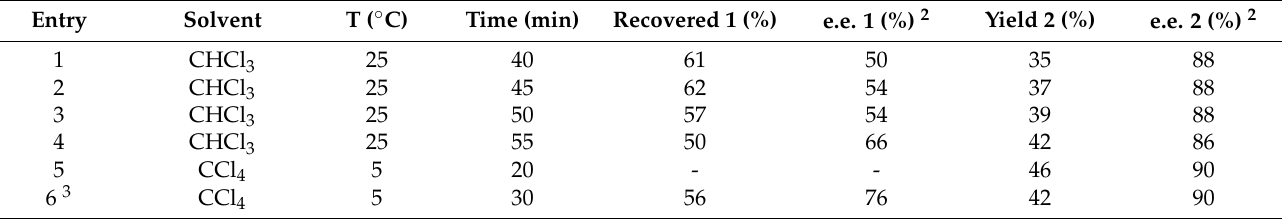
Table 1. Preliminary kinetic resolution studies 1 .